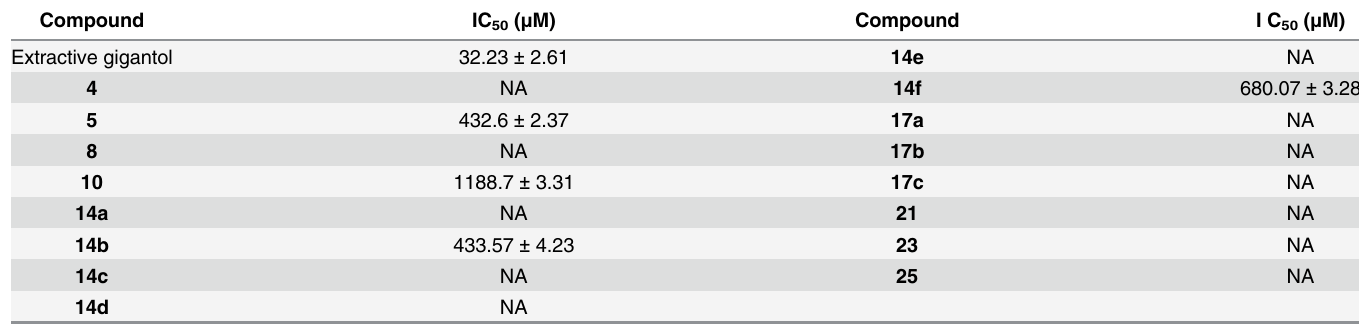
Table 2. Inhibitory effect of gigantol and its analogs on iNOS activity 1 .